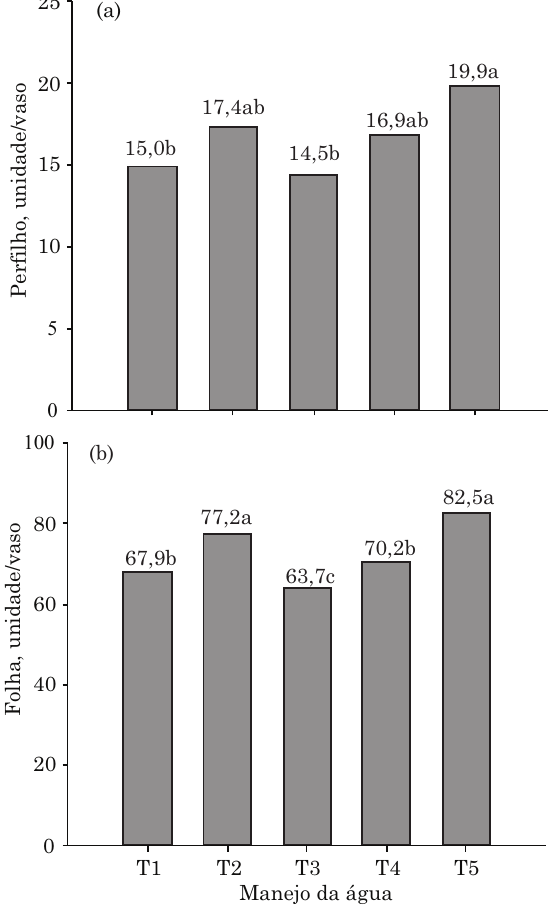
Figura 2. Concentração de ferro na parte aérea do arroz aos 42 (a) e 70 (b) dias, após a emergência (DAE).